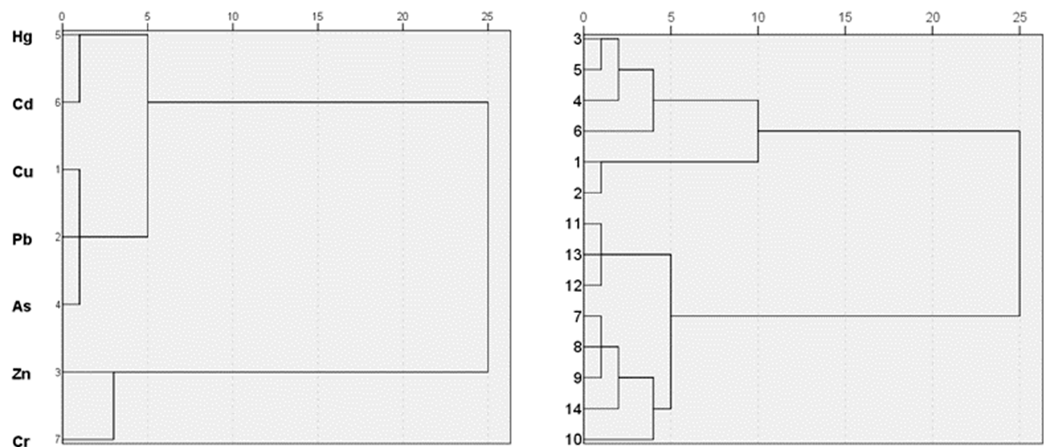
Figure 6. Cluster analysis results in 2015.